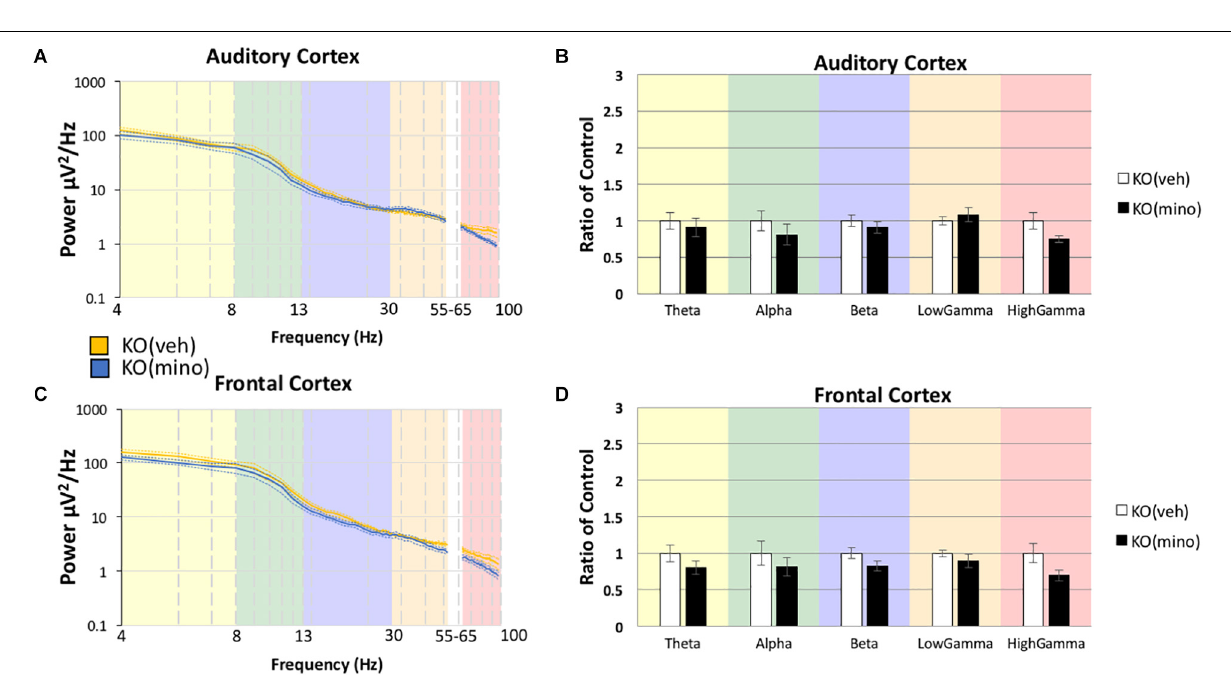
Frontiers in Neuroscience |